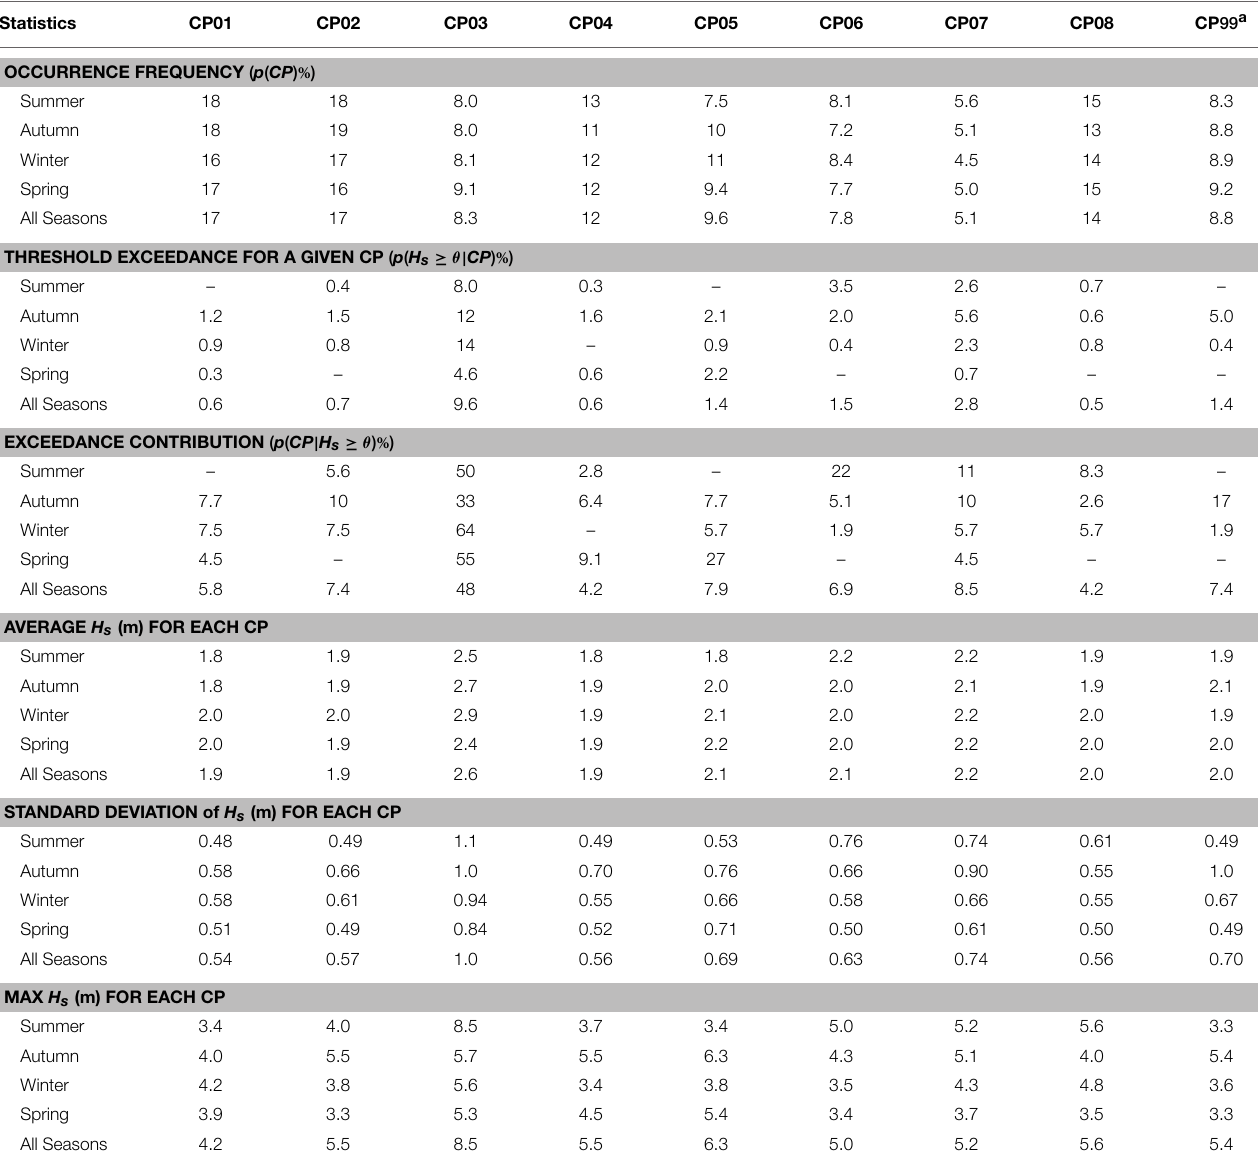
TABLE 3 | CP Occurrence frequencies and wave height statistics associated with each CP